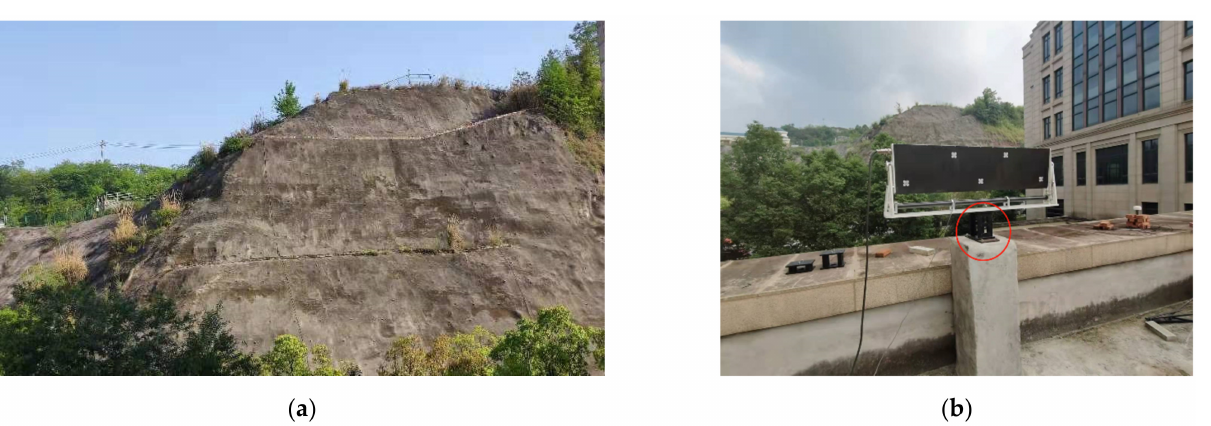
Figure 9. Experimental information. ( a ) Scene photo. ( b ) GB-MIMO radar system.